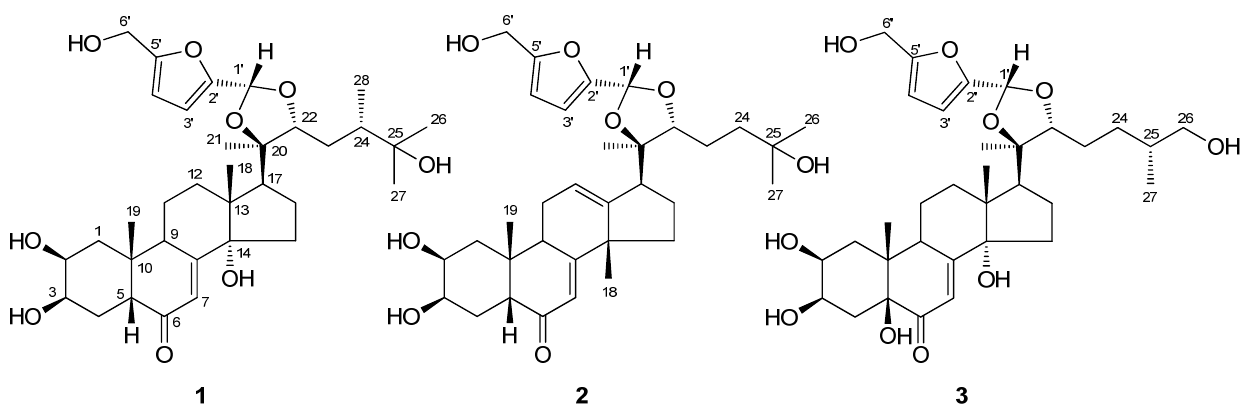
Figure 1. Structures of compounds 1 - 3